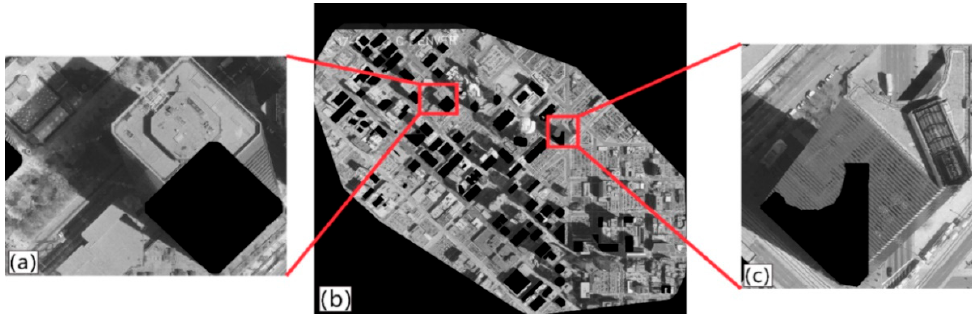
Figure 14. Generation results of DTM-based T 2 OM on dataset 1. ( b ) DTM-based T 2 OM; ( a , c ) are enlarged windows of the two regions.